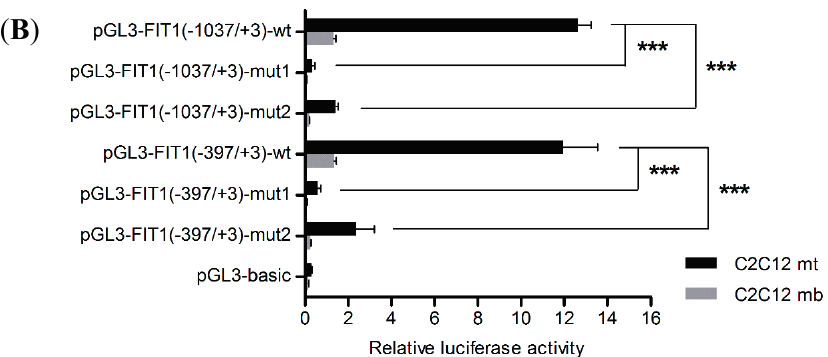
Figure 3. Activities of porcine FIT1 promoter in which either E-box element was site-directed mutated during C2C12 myogenesis. ( A ) Schematic structures of various site-directed mutants of either E-box site in the fragment − 397/+3. mut1 denotes the sequence of the E-box1 site alone mutated from CACCTG to CAAATT and mut2 denotes the sequence of E-box2 site alone mutated from CAGCTG to CAAATT, each indicated with a red check mark, respectively. The mutated bases are indicated in red; ( B ) the activities of wild-type fragments ( − 397/+3 and − 1037/+3, respectively) and different mutants of porcine FIT1 promoter in undifferentiated and differentiated C2C12 cells. Data are the means ± SD ( n = 3). *** p < 0.001 relative to the values of wild-type fragments (2-tailed